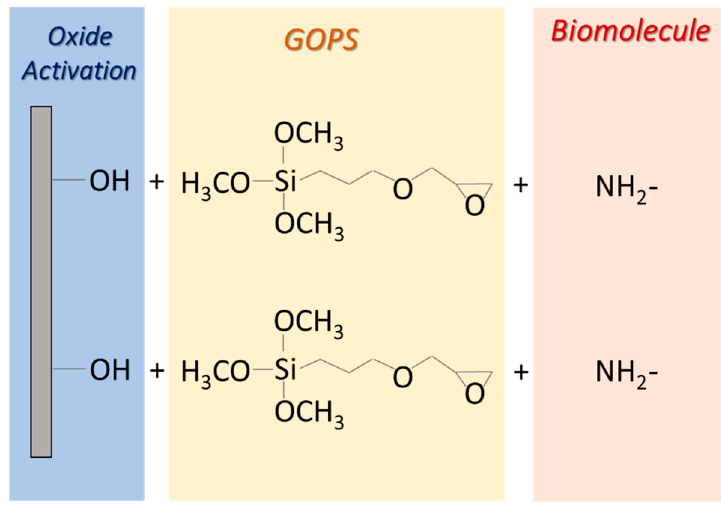
Figure A2. Schematic view of GOPS protocol optimized for biomolecule immobilization.